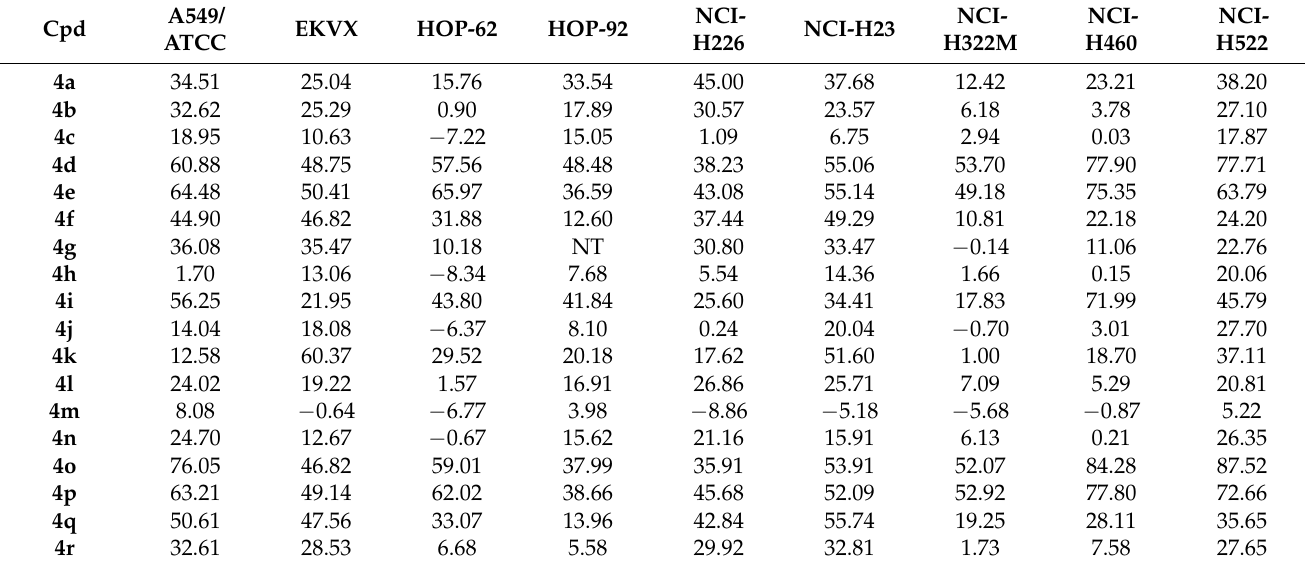
Table 6. Anti-proliferative activities (% growth inhibition) of the target compounds 4a – r against non-small cell lung cancer cell lines.